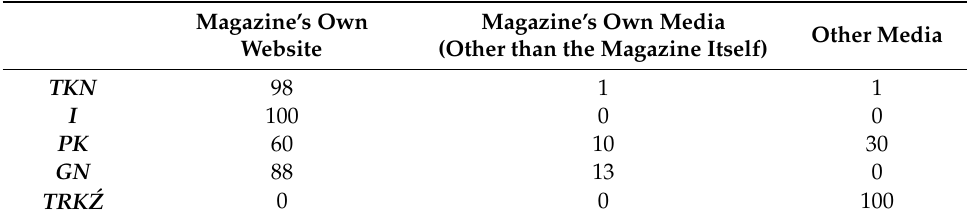
Table 9. The published links transfer to ... (%).